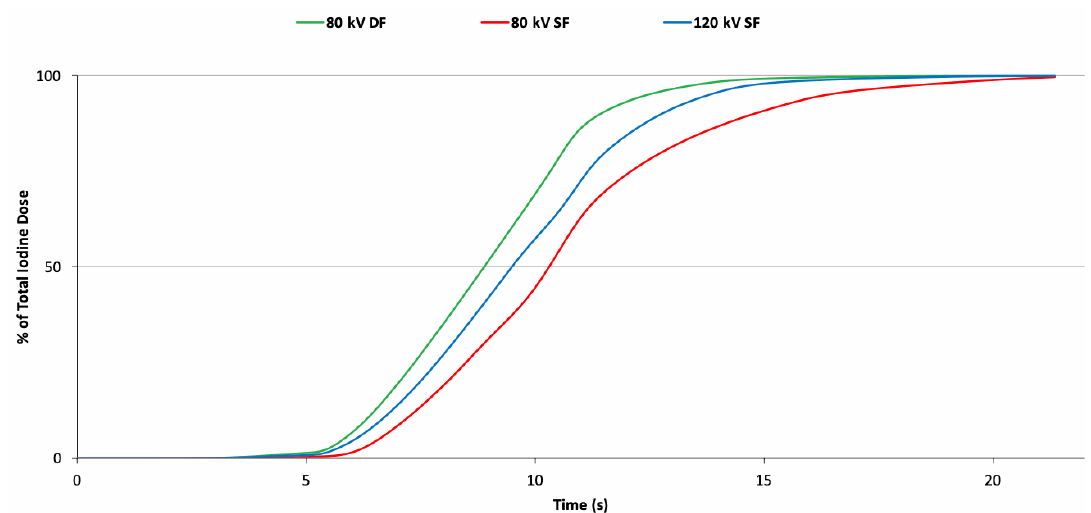
Figure 2. Fluid delivery measurements. Fluid delivery measurements for different injection protocols. Green curve represents the 80 kV DF protocol; red curve represents the 80 kV SF protocol; blue curve represents the 120 kV SF protocol.